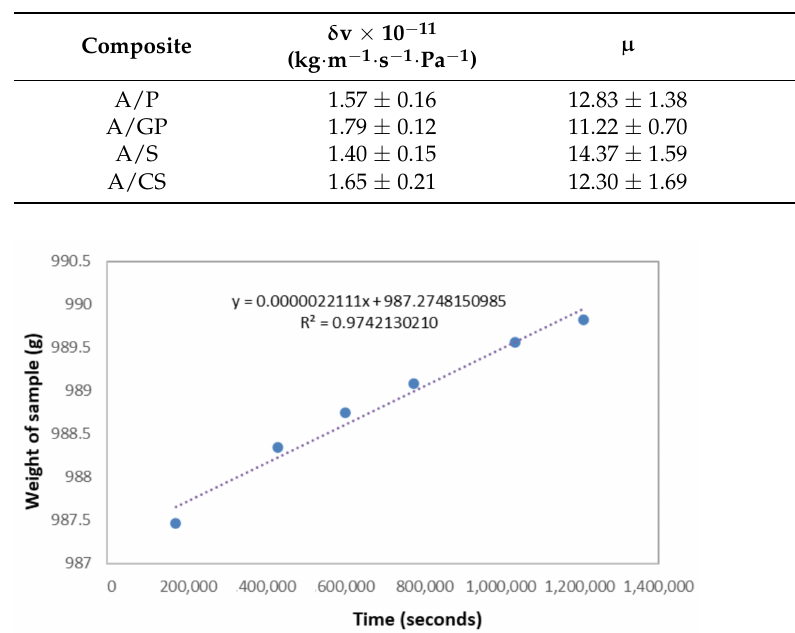
Table 2. Permeability and vapor resistance of the four composites (mean ± SD).